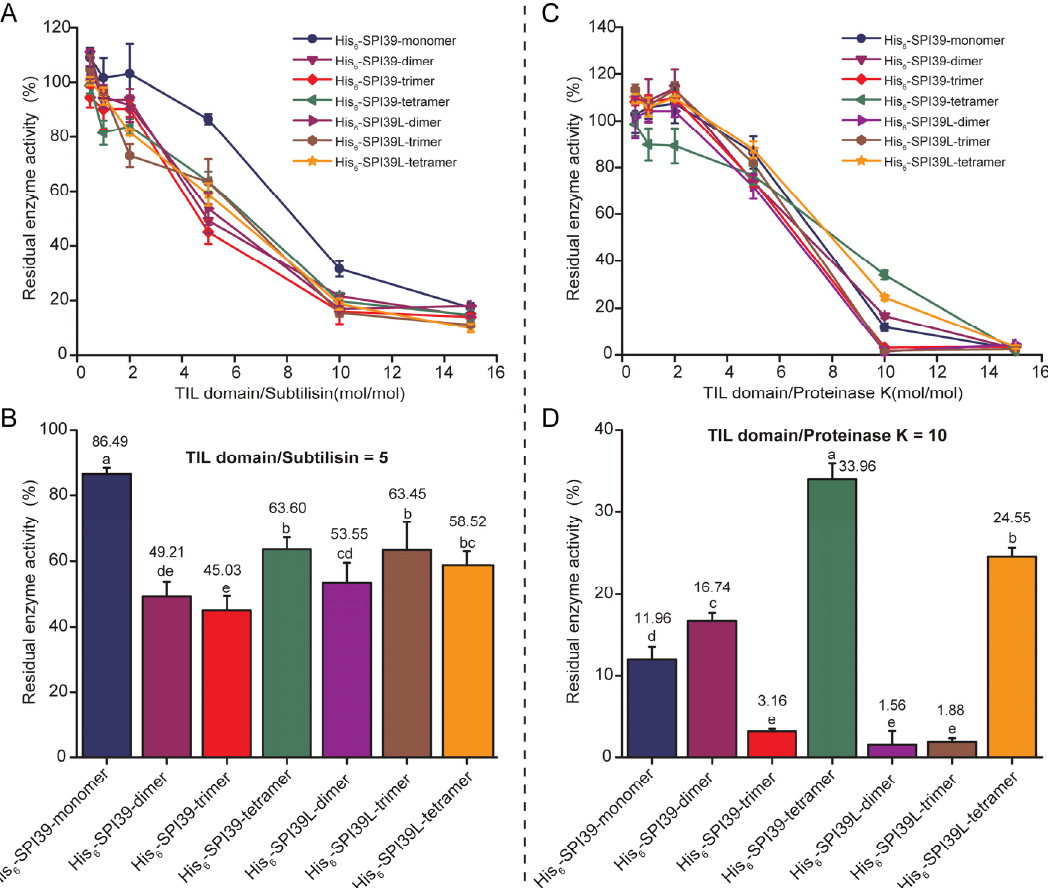
Figure 4. Comparison of inhibitory capacity of BmSPI39 tandem multimers against microbial protease using protease inhibition assays. ( A ) Inhibitory effects of increasing concentrations of BmSPI39 tandem multimers against subtilisin A from B. licheniformis ; ( B ) inhibitory activities of BmSPI39 tandem multimers against subtilisin when the ratio of TIL domain to protease is 5; ( C ) inhibitory effects of increasing concentrations of BmSPI39 tandem multimers against proteinase K from E. album ; ( D ) inhibitory activities of BmSPI39 tandem multimers against proteinase K when the ratio of TIL domain to protease is 10. Error bars represent the standard error of the mean ( n = 3). Different letters “a–e” indicate a significant difference between groups ( p < 0.05), and one identical letter indicates no significant difference between groups ( p < 0.05).